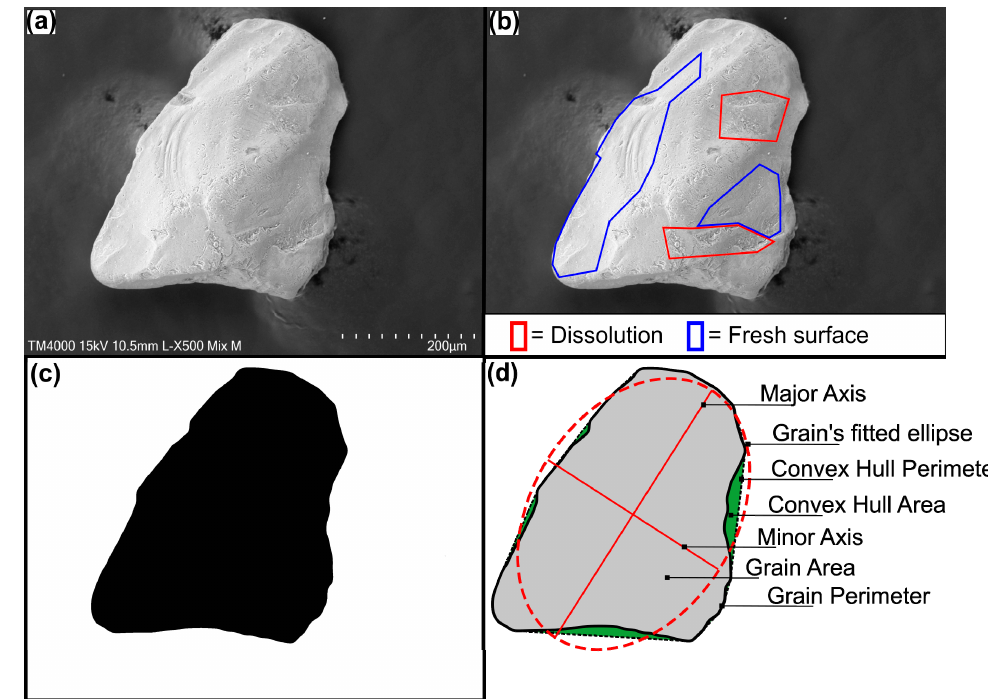
Figure 3. Steps of the quartz grain image processing. ( a ) Original SEM—image. ( b ) Marking of areas with dominant microtextural family. The remaining area is calculated automatically (here percussion marks). ( c ) Binary image after the segmentation procedure to separate the grain from the background. ( d ) Representation of the measured parameters using ImageJ.